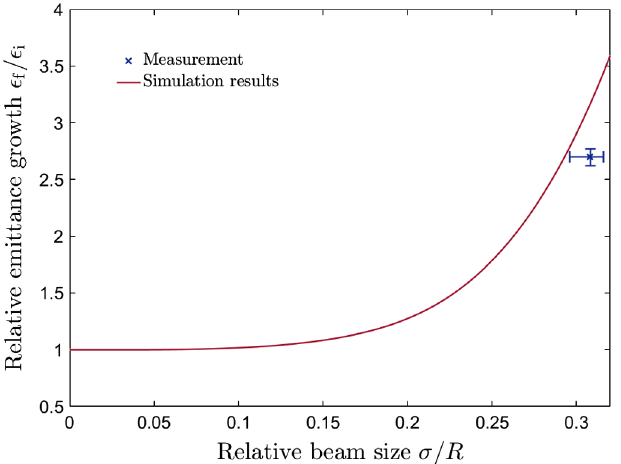
FIG. 7. Particle tracking simulation results for relative emit- tance degradation of a MaMi-like beam in dependence of incoming rms beam size for an APL with R ¼ 0 . 5 mm and I 0 ¼ 364 A. The measured emittance degradation for this setup is also